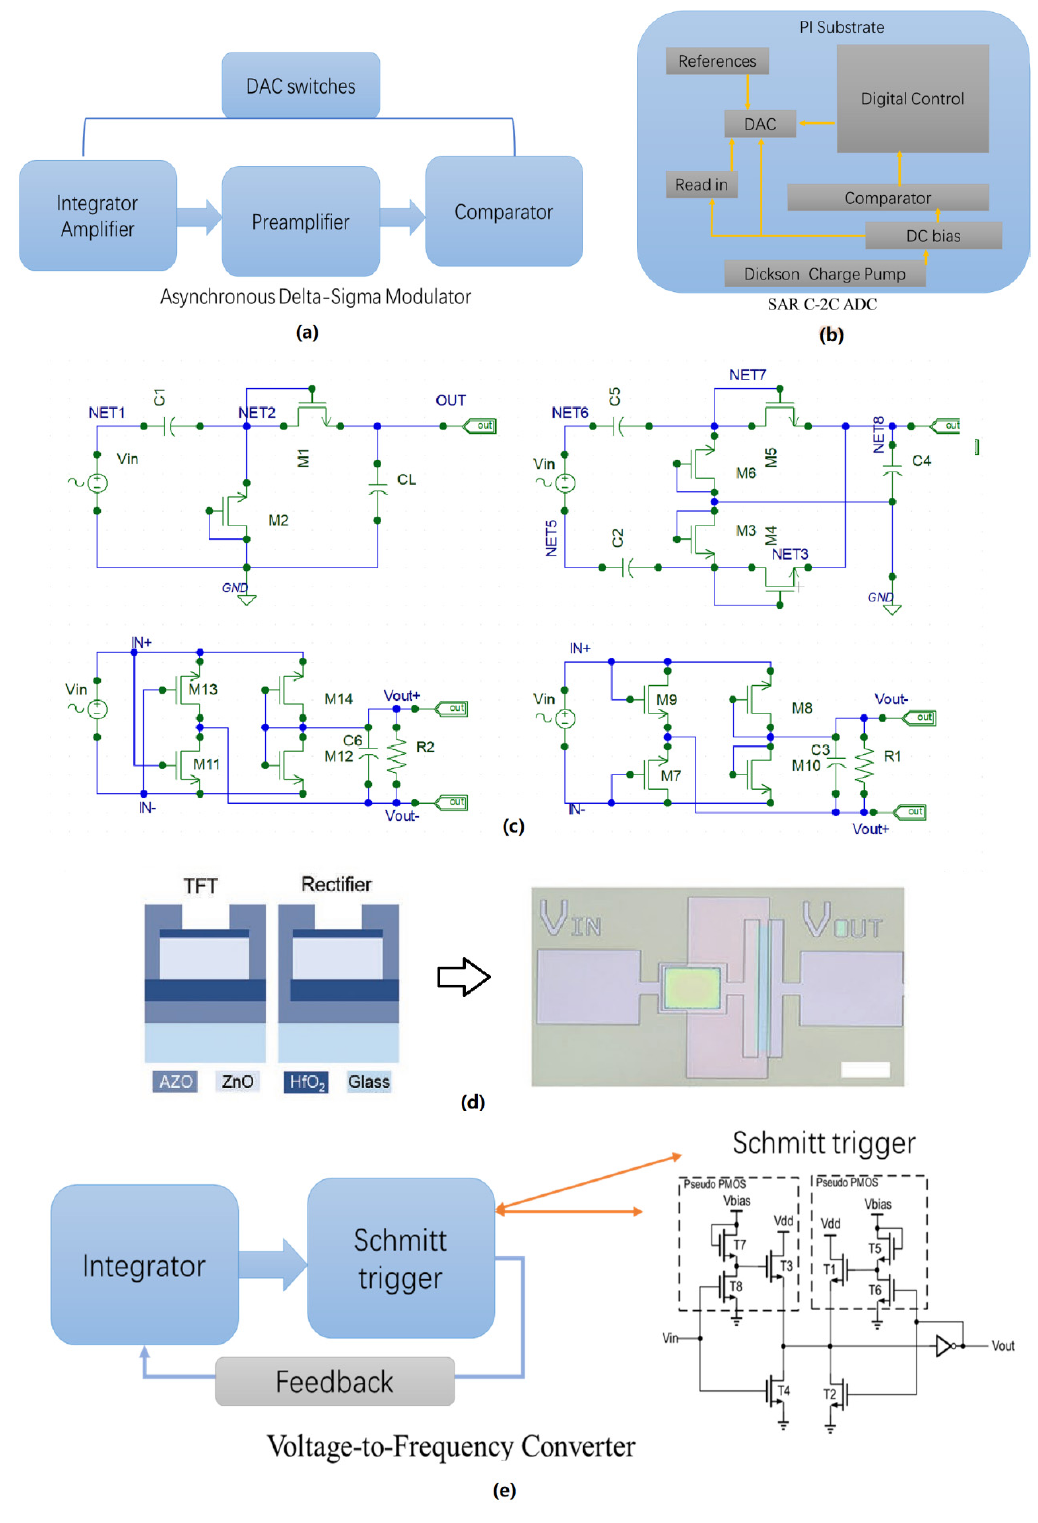
Figure 15. Other analog circuits based on oxide TFTs: ( a ) Diagram of the asynchronous delta-sigma modulator, ( b ) Diagram of SAR C-2C ADC, ( c ) Four kinds of rectifiers, ( d ) Field-effect rectifiers [163], and ( e ) Diagram of voltage-to-frequency converter and Schmitt trigger.